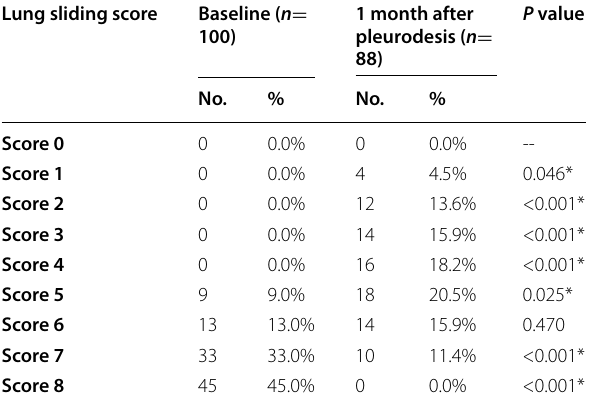
Table 4 Baseline and follow-up lung sliding score by chest ultrasound in studied patients Lung sliding